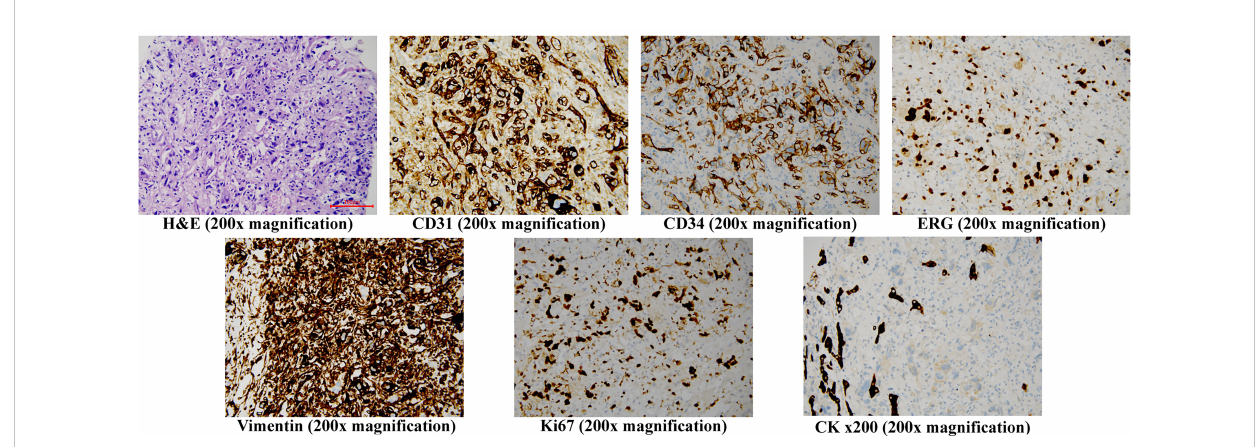
FIGURE 2 Histopathology staining of the core needle liver biopsy specimen H&E (200x magni fi cation) shows cells with pleomorphic nuclei and frequent mitotic fi gures, solid nodules of similar atypical spindled endothelial cells and focal areas of with epithelioid morphology. Immunohistochemistry (200x magni fi cation) shows the cells to be positive for CD31, CD34, ERG, Vimentin and Ki67, but negative for CK, H&E, hematoxylin and